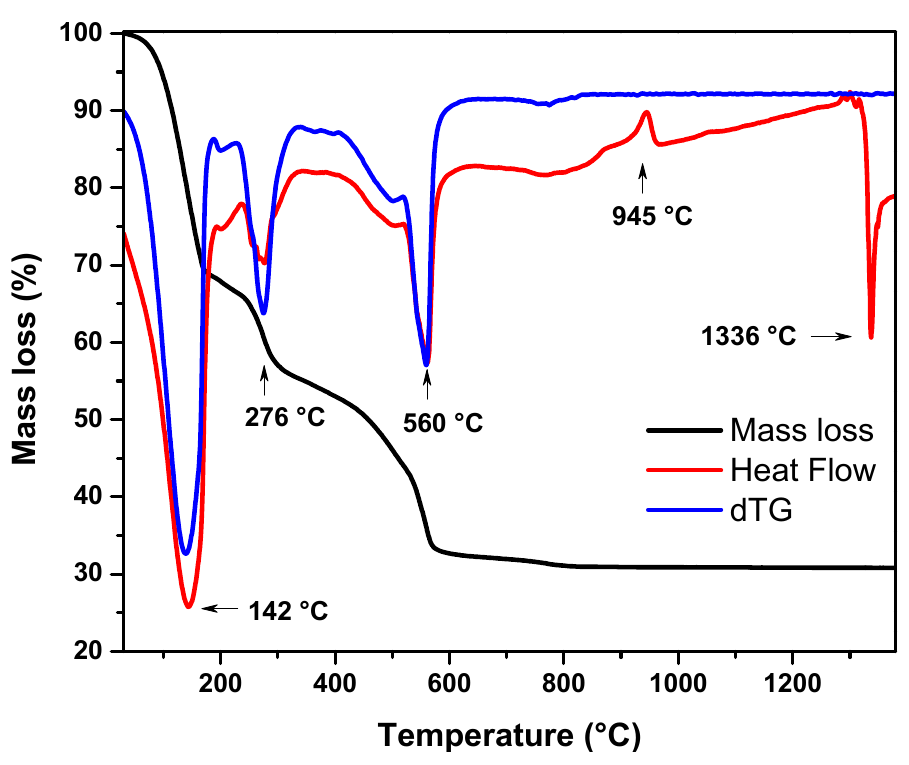
Figure 1. TG-DTA thermograph of the initial synthesized material. The TG-DTA analysis performed on the material under study (Figure 1) showed a total mass loss of 70% up to 835 ◦ C, which occurred in four